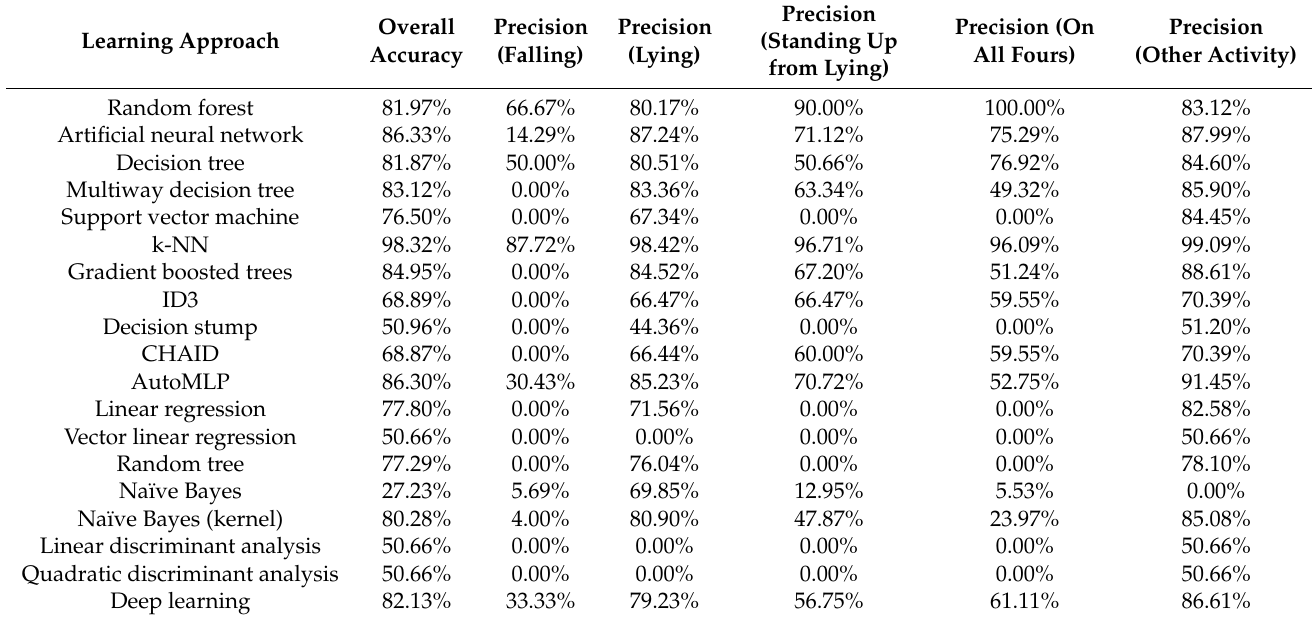
Table 3. Summary of the performance characteristics of the different machine learning methods that we developed in RapidMiner to detect falls and fall-related motions by using the first dataset